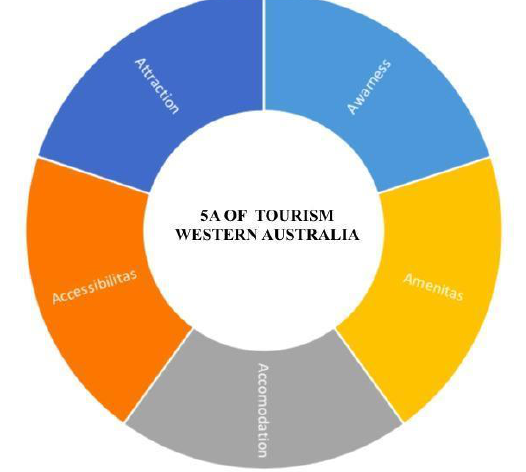
Figure 2. 5A Concepts by Tourism Western